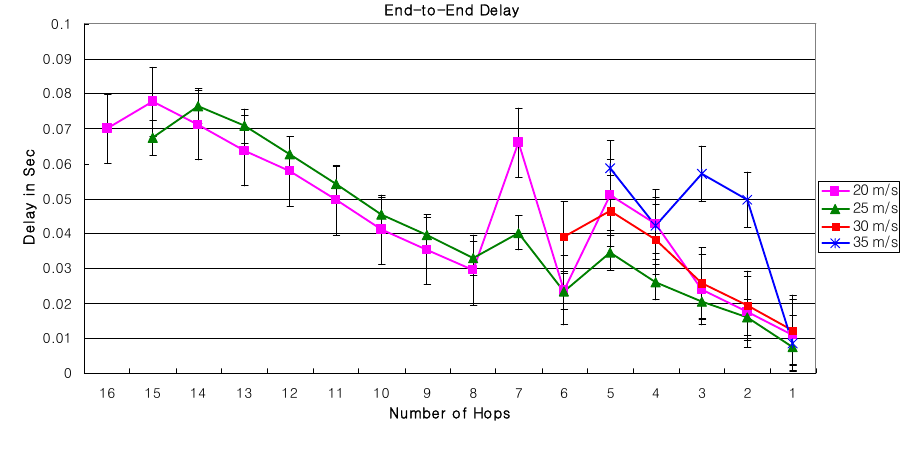
Figure 16. Delay vs. number of hops with variable MN’s speed (LoWMob). End-to-End